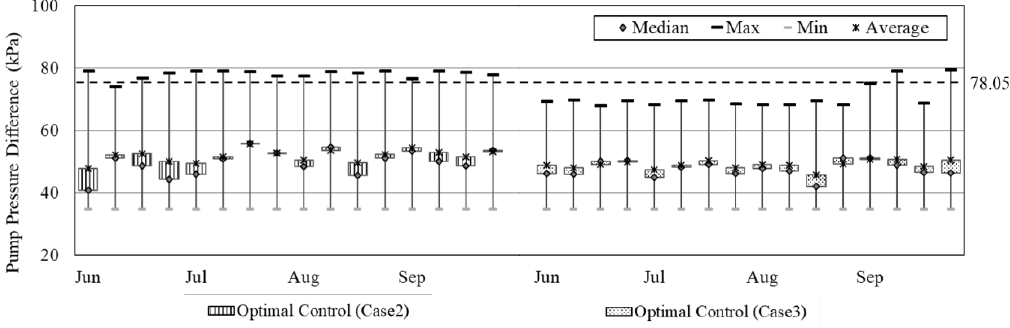
Figure 7. Pump pressure differences during optimal control mode for June through September.